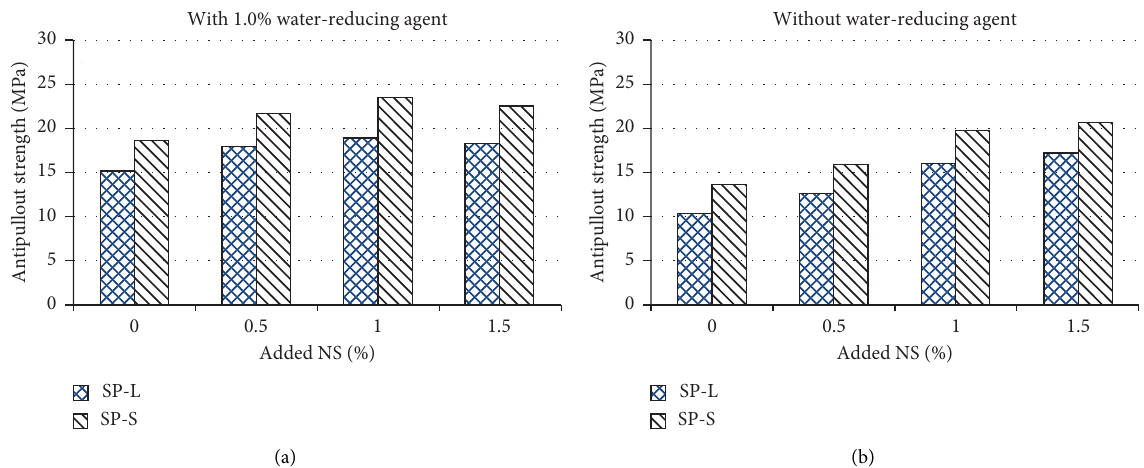
Figure 5: Variation of the antipullout strength with added NS for two different sizes: (a) with 1.0% water-reducing agent; (b) without the water-reducing agent.